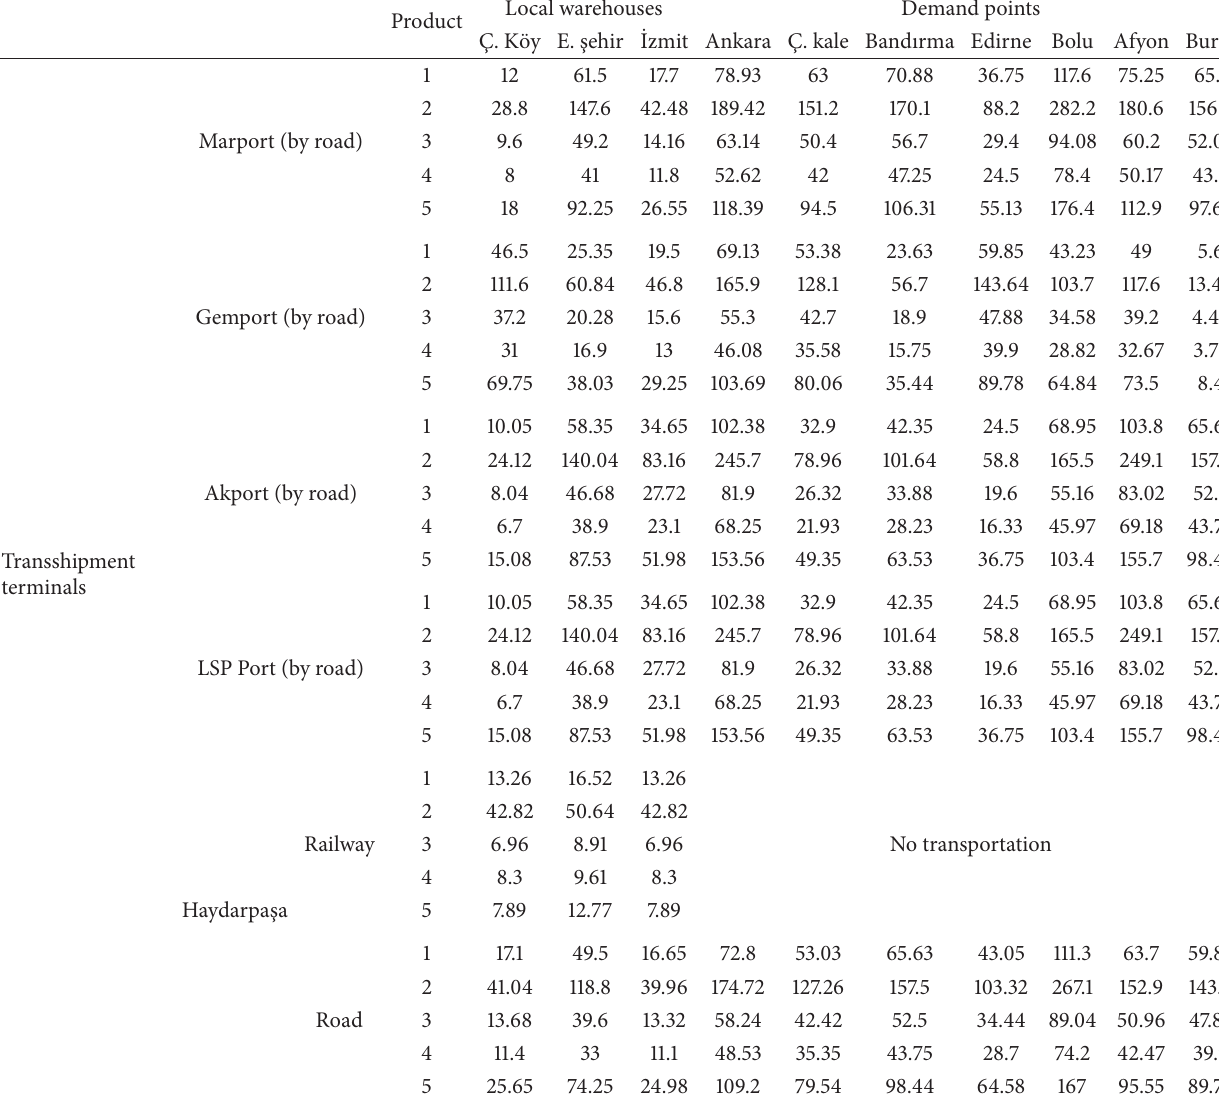
Table 7: Transportation costs from the second transshipment terminals to local warehouses and demand points in Turkey